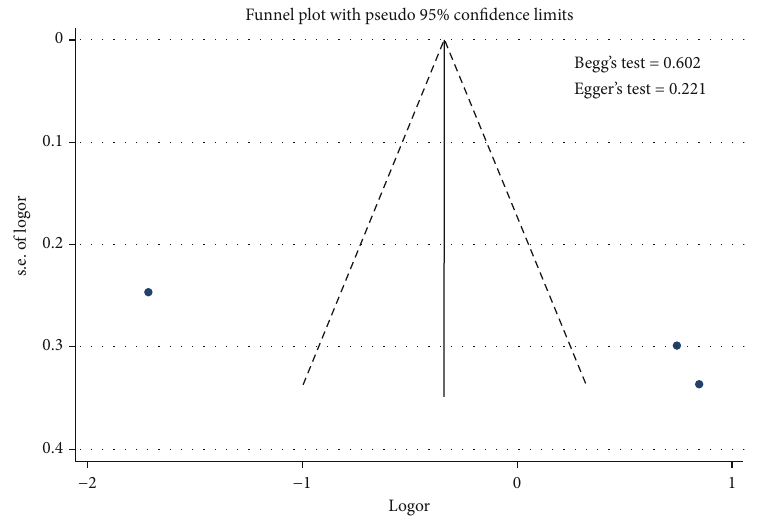
Figure 9: Funnel plots role of diabetes on the uncontrolled hypertension.